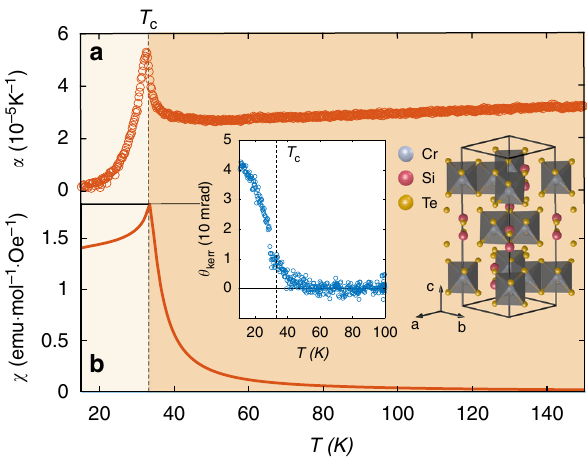
Fig. 1 Characterization of long-range spin ordering in CrSiTe 3 . Temperature dependence of the a c -axis thermal expansion coef fi cient, b magnetic susceptibility and (left inset) magneto-optical Kerr rotation angle from a bulk single crystal of CrSiTe 3 showing the clear onset of long-range magnetic order at T c ~ 31 K. Note the absence of any features above T c in all of these measurements. Right inset shows the crystal structure of CrSiTe 3 . In the FM phase, the Cr 3 + spins all point parallel to the c